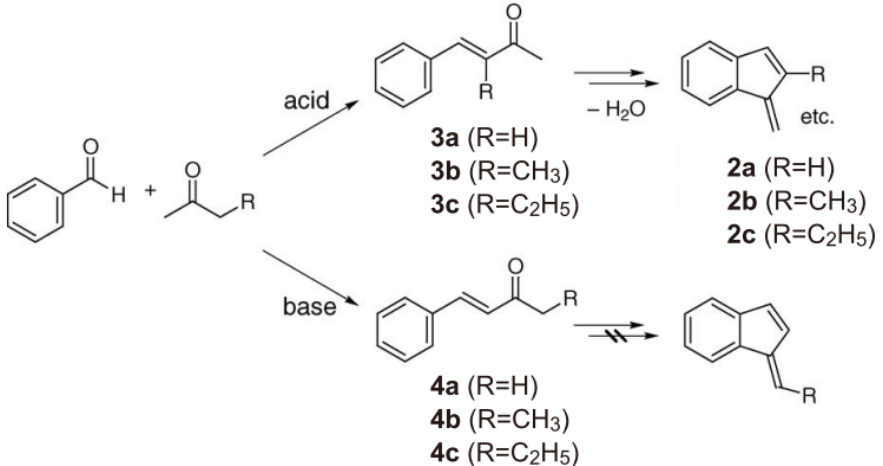
Scheme 3. Different regioselectivities for the aldol condensation of unsymmetrical aliphatic ketones over acid and base